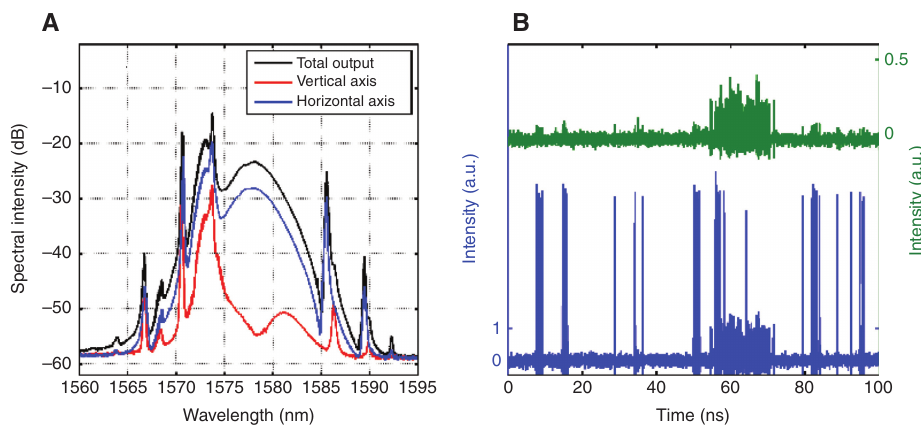
Figure 5: Dual-wavelength operation of the gain-guided dissipative soliton fiber laser: scalar and vector gain-guided dissipative solitons. (A) Polarization-resolved optical spectra. (B) The corresponding polarization-resolved oscilloscope trace.